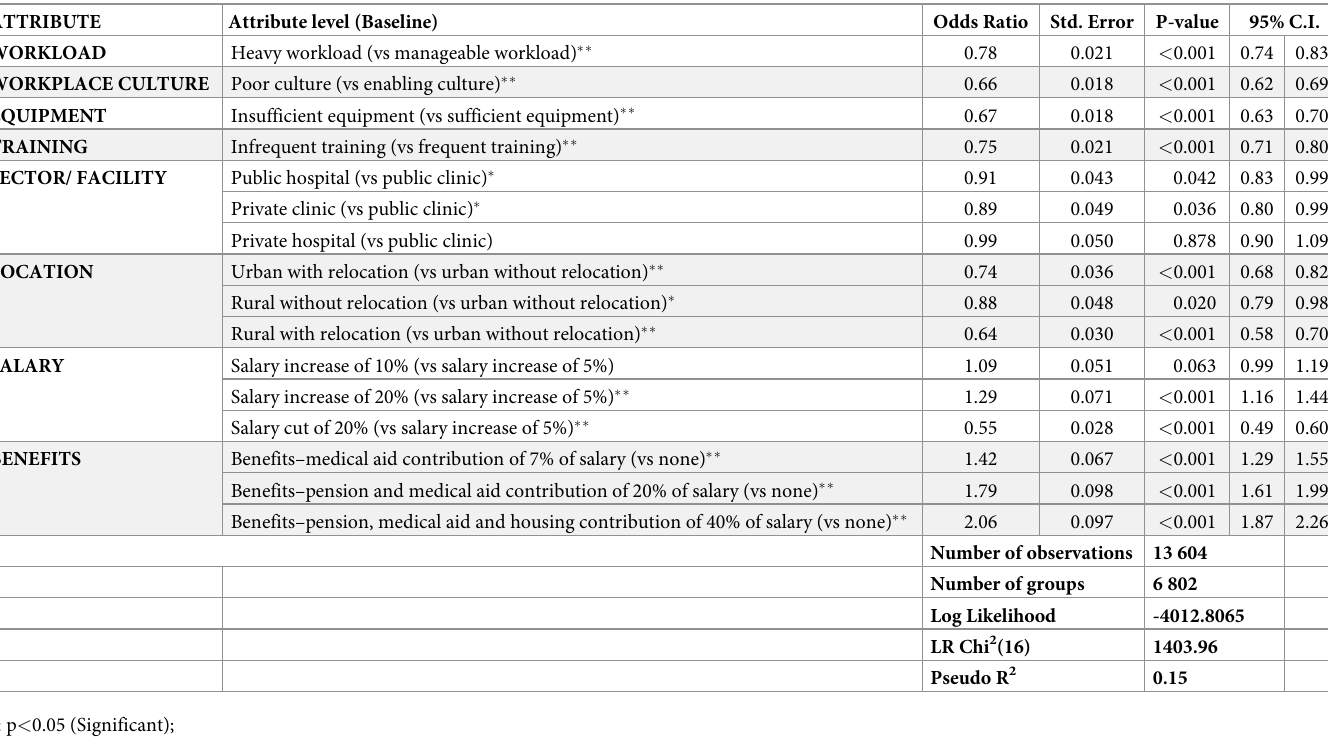
Table 4. Main effects fixed logit